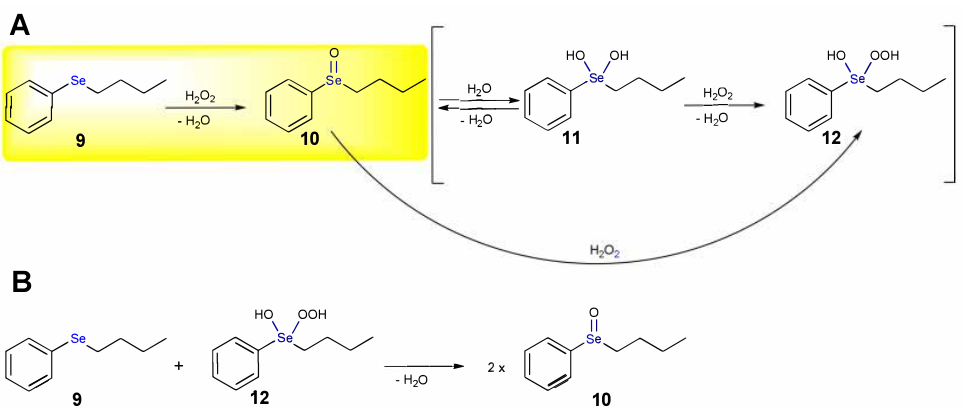
Scheme 7. Oxidation mechanism of n-butyl phenyl selenide by H 2 O 2 ( A ) and by the hydroxy perhydroxy selenane 12 ( B ). The direct oxidation step is